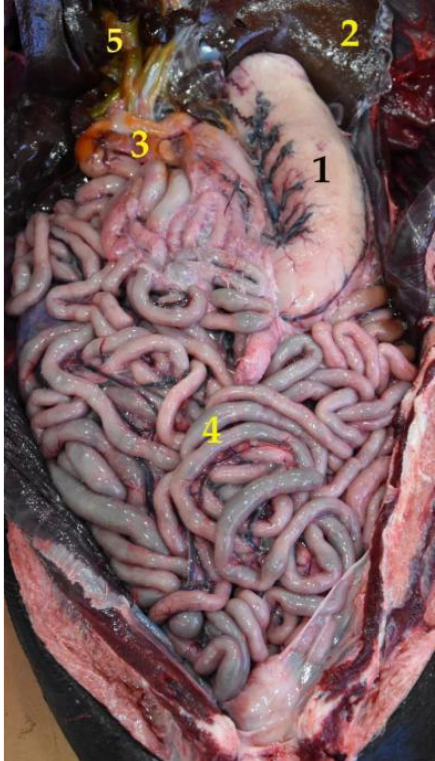
Figure 6. Topographical arrangement of the abdominal cavity (body in dorsal recumbency). The liver has been removed to see the gallbladder. ( 1 ) Stomach; ( 2 ) liver; ( 3 ) duodenum; ( 4 ) jejunum; ( 5 ) gallbladder.